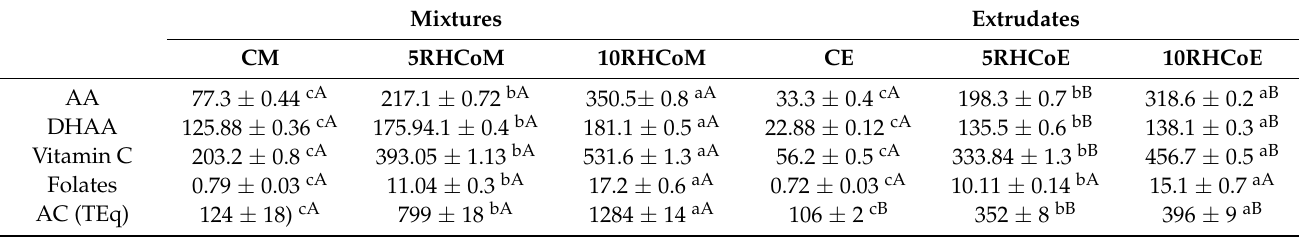
For each parameter, different small letter in superscript within row indicates significant differences between samples ( p < 0.05) comparing samples in mixtures or extrudates. For each sample and parameter, a different capital letter in superscript within row indicates significant differences between samples ( p < 0.05) comparing mixtures and extrudates. Samples were mixtures (M) and extrudates (E); C: Control, 5RHCo: 5% of rosehip co-product and 10RHCo: 10% of rosehip